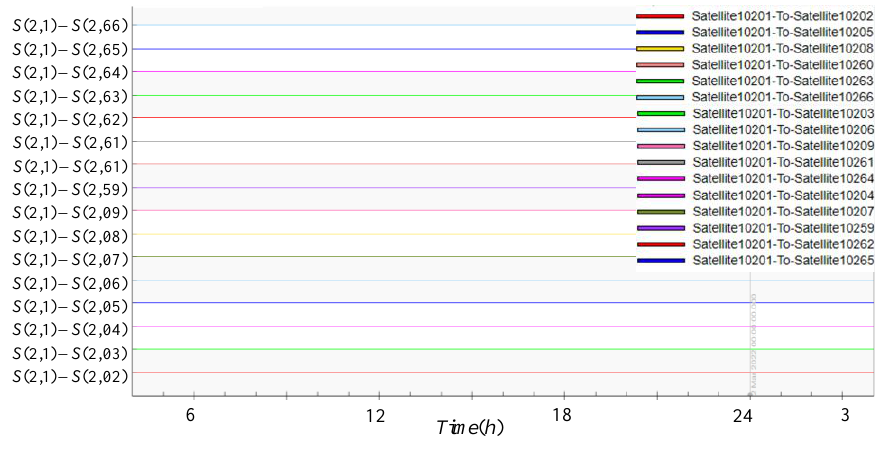
Figure 9. Visibility analysis of Co-orbiting satellites.